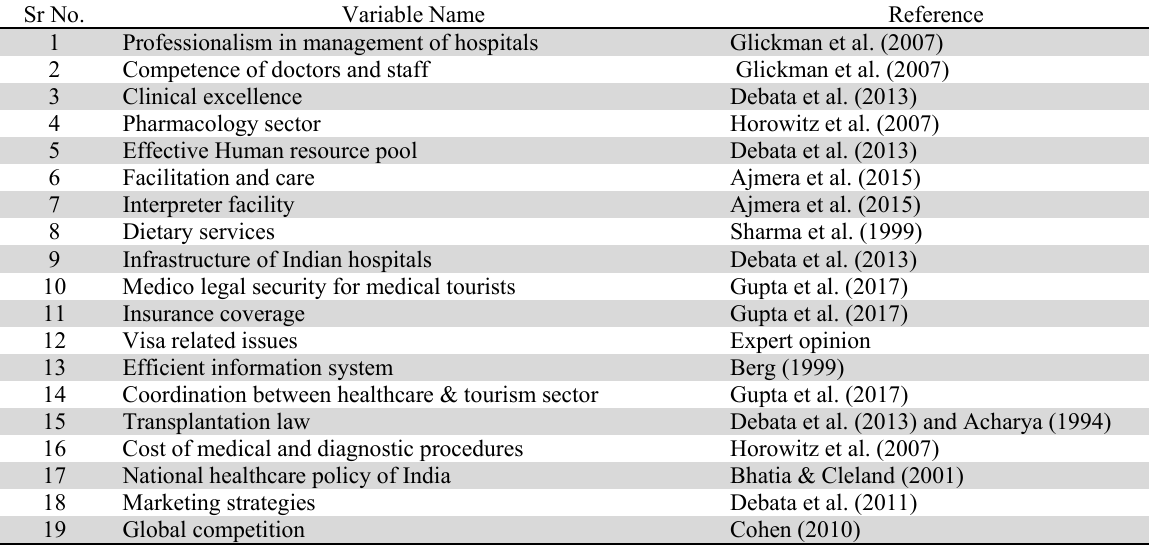
Indian Medical Tourism variables and their references Sr